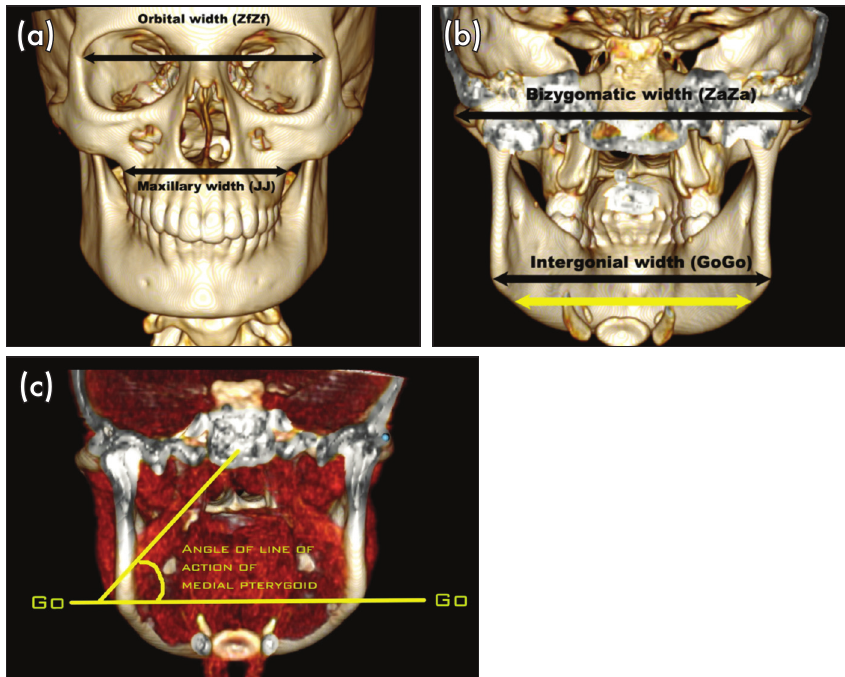
Figure 2. Both the skeletal (a), (b) and muscular (c) viewing modes were used to assess the osseous facial width and the line of action of right medial pterygoid muscle, from the coronal view.